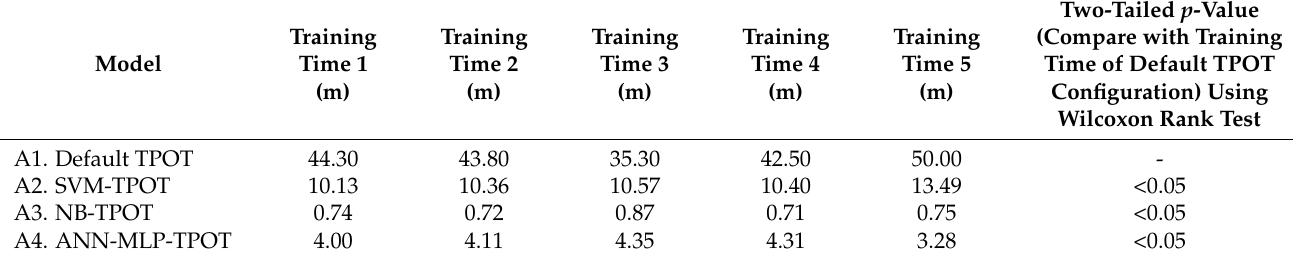
Table 8. Training time for all TPOT